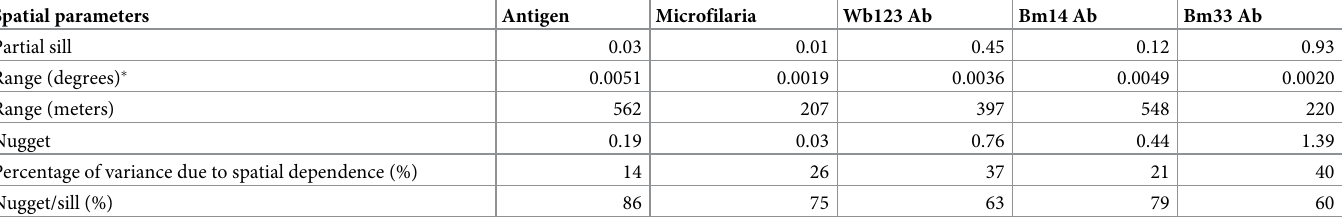
Table 2. Parameters of significant spatial autocorrelation for lymphatic filariasis antigen, microfilaria and antibodies (Bm14, Bm33 and Wb123), American Samoa 2016.